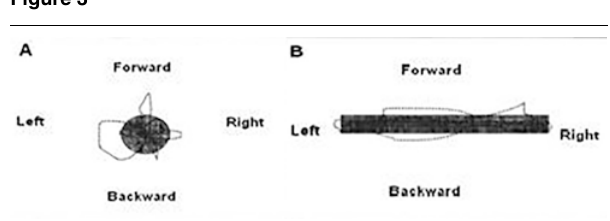
Visual biofeedback training screen.